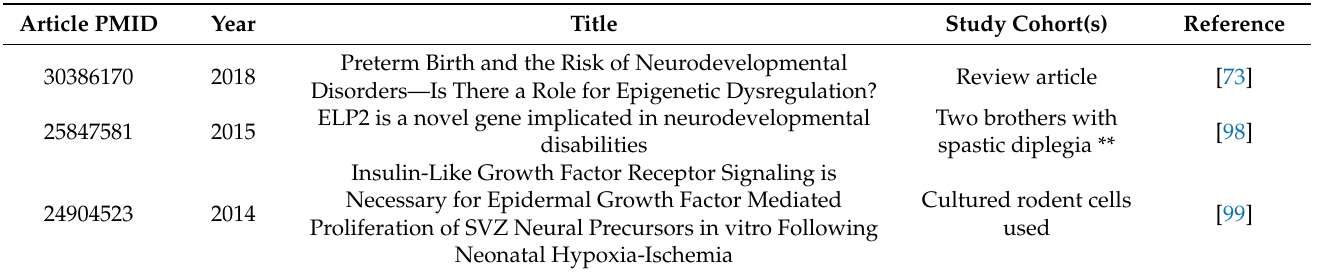
Table 2. Studies associating histone modification with CP